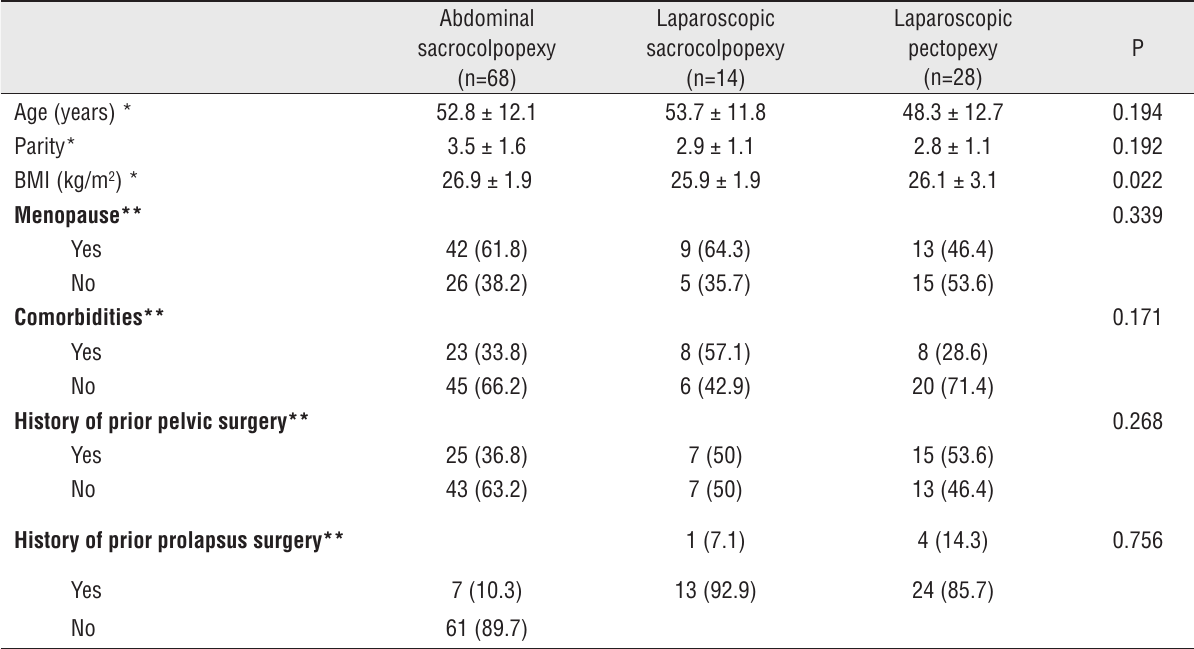
Table 1 - patients’ preoperative characteristics in the study groups.